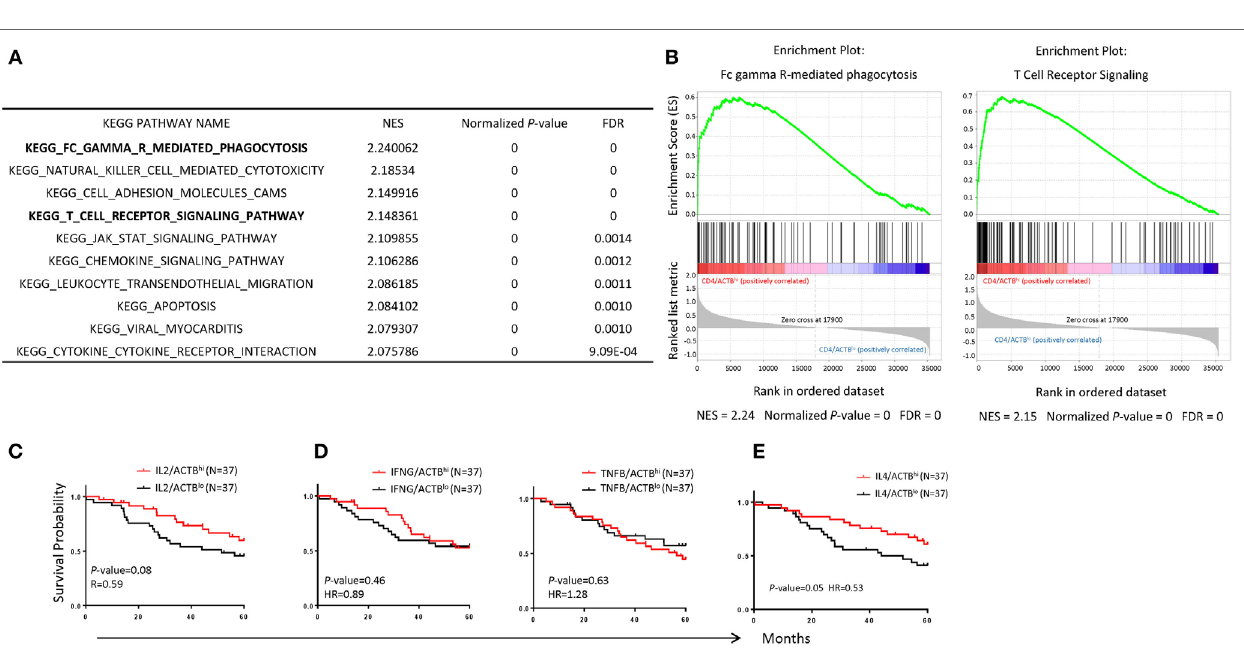
FigUre 6 | Immunological mechanisms underlying the association between CD4 T cells and prognosis of neuroblastoma (NB) patients. (a) Top 10 significant KEGG pathways enriched in NB samples with CD4 hi . The normalized enrichment score normalized P -value and false discovery rate are displayed on the graphs. (b) Gene set enrichment analysis enrichment plot showing significant enrichment of upregulated pathways (Fc gamma R-mediated phagocytosis; left, T cell receptor; right) in NB samples with CD4 hi . (c–e) Kaplan–Meier curves showing 5-year survival of NB patients according to their IL2 (c) , IFNG , and TNFB (D) , and IL4 (e) gene expression normalized with the ratio of actin expression. The NB samples were divided into high- and low-groups based on their upper and lower quartile of RNA-seq data. The hazard ratio and P -value displayed on the graphs are from the log-rank test and Gehan–Breslow–Wilcoxon